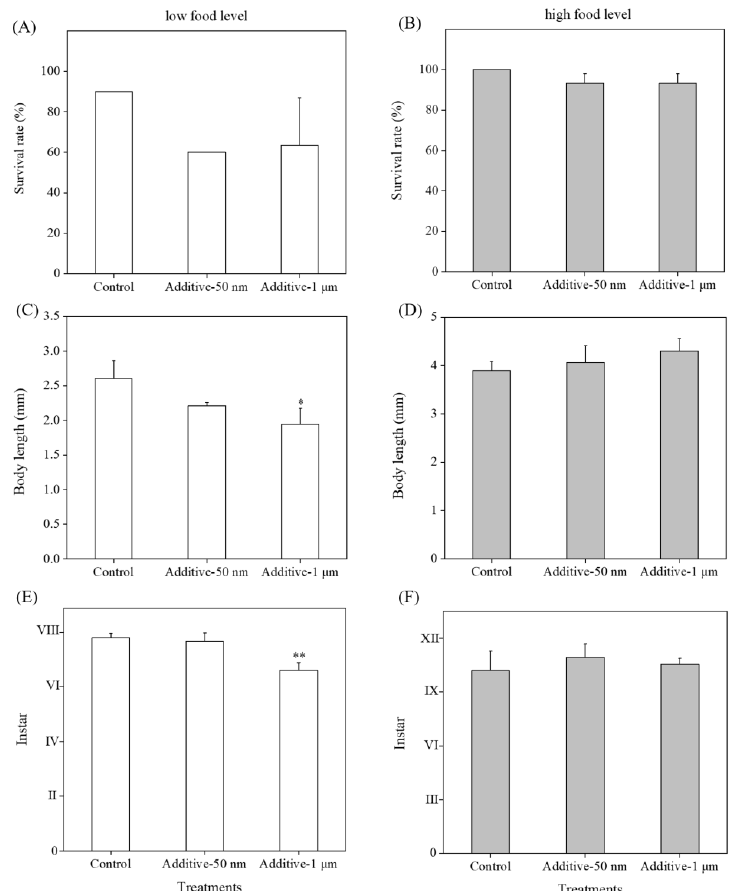
Figure 4. Impacts of additives extracted from 50 nm and 1 μm PS-NH 2 on survival rate (%), body length (mm) and instar for A. parthenogenetica upon 14 day exposure to low food levels ( A , C , E ) and high food levels ( B , D , F ). Column bars represent means values ± SD and differences between exposure groups and controls are shown as * ( p < 0.05) and ** ( p < 0.01) using one-way ANOVA with Dunnett’s post hoc test.